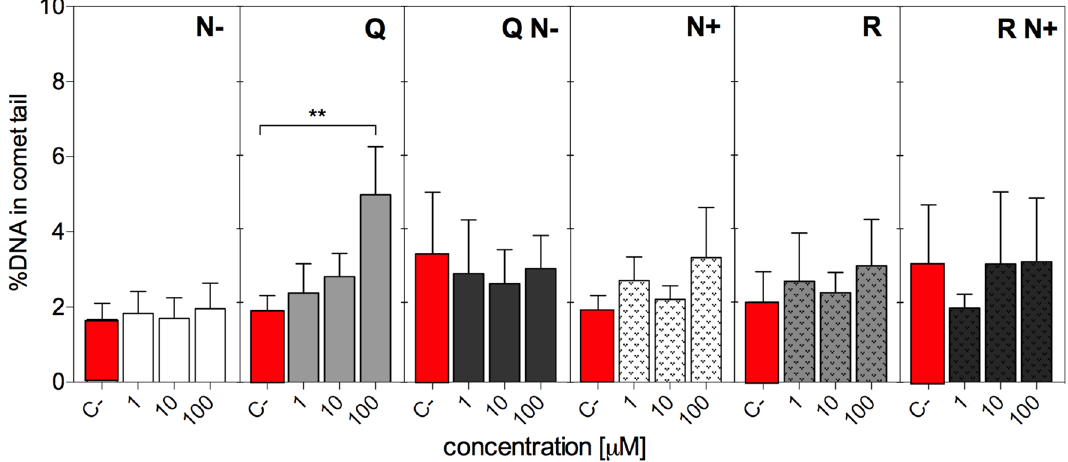
Figure 5. Genotoxicity of tested flavonoids (1–100 μM) and their mixtures containing equal concentrations of each compound (1–100 μM) in HT29 cells evaluated with the aid of comet assay and expressed as %DNA in the comet tail. Results represent means ± SD of three independent experiments. Negative control (C-) refers to cells treated with solvent only. Significantly different values determined by one-way ANOVA with Dunnett’s test are marked as: ** p ≤ 0.01.